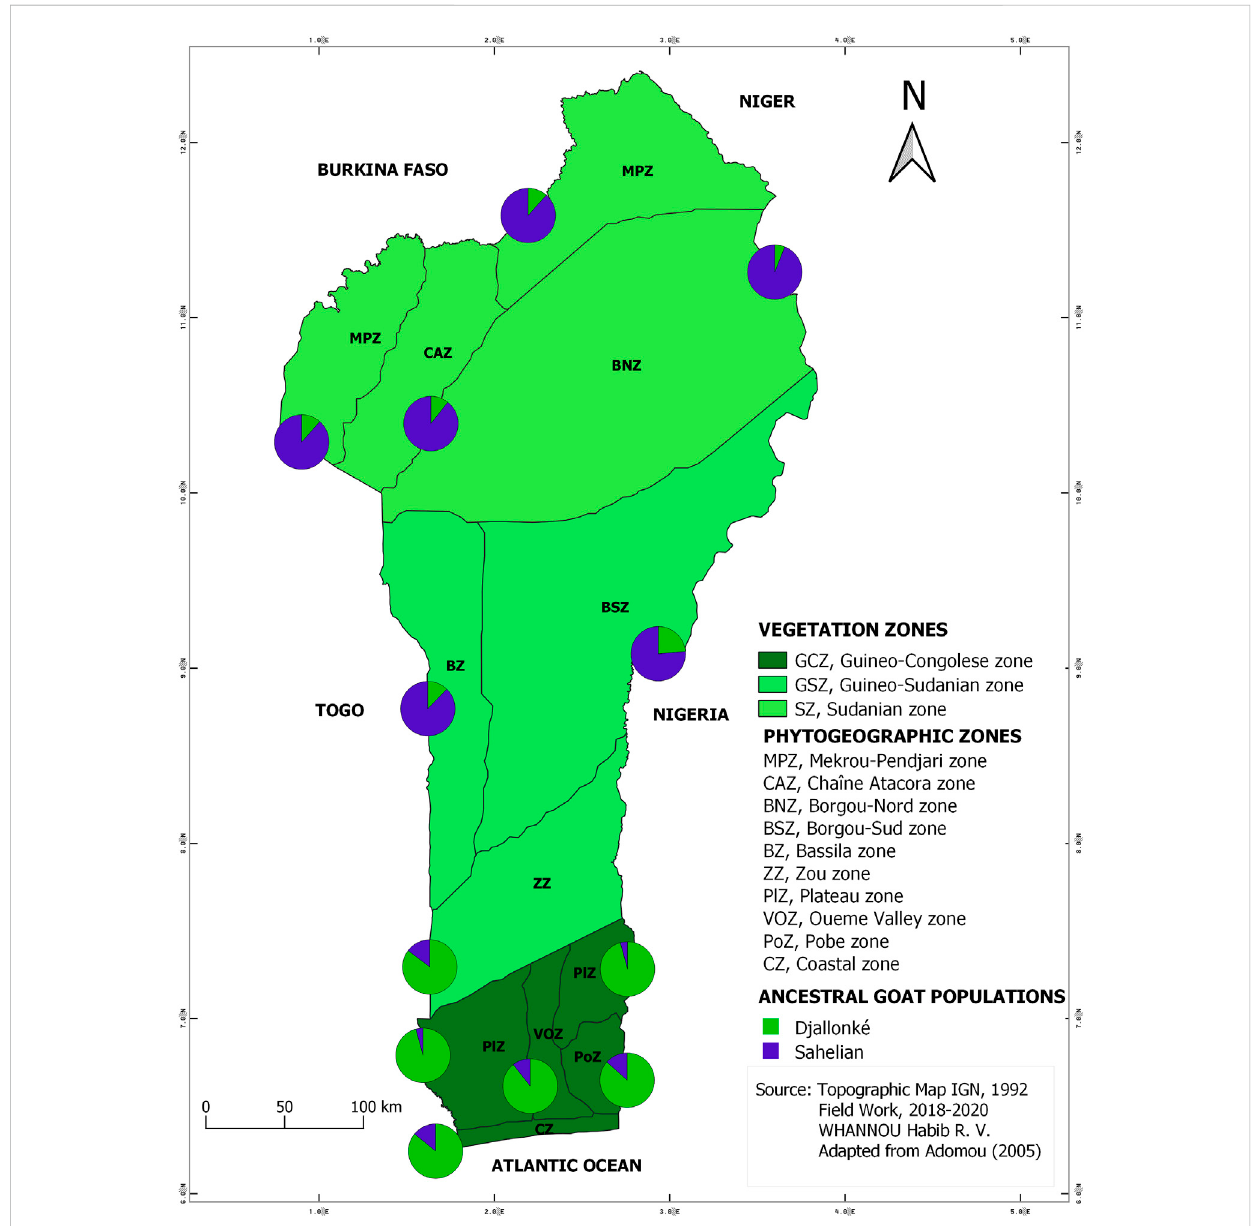
FIGURE 3 Map of the spatial distribution of the two inferred ancestral populations based on membership assignment from the population structure analysis following vegetation and phytogeographic zones patterns.